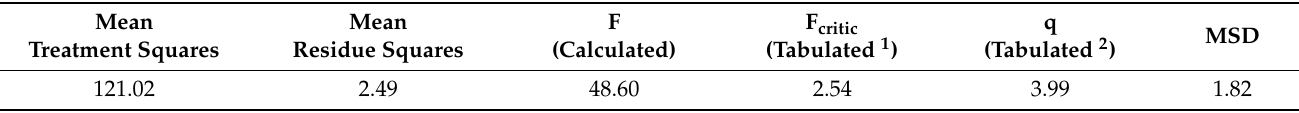
Table 8. ANOVA and Tukey’s test statistical parameters for composites elastic